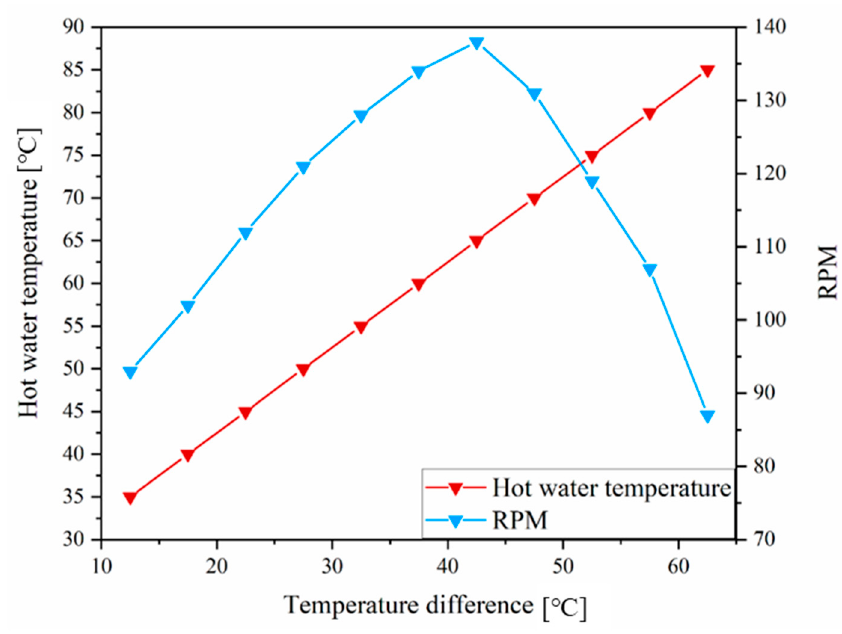
Figure 8. The effect of temperature difference on RPM of the cylindrical thermomagnetic heat en- gine.